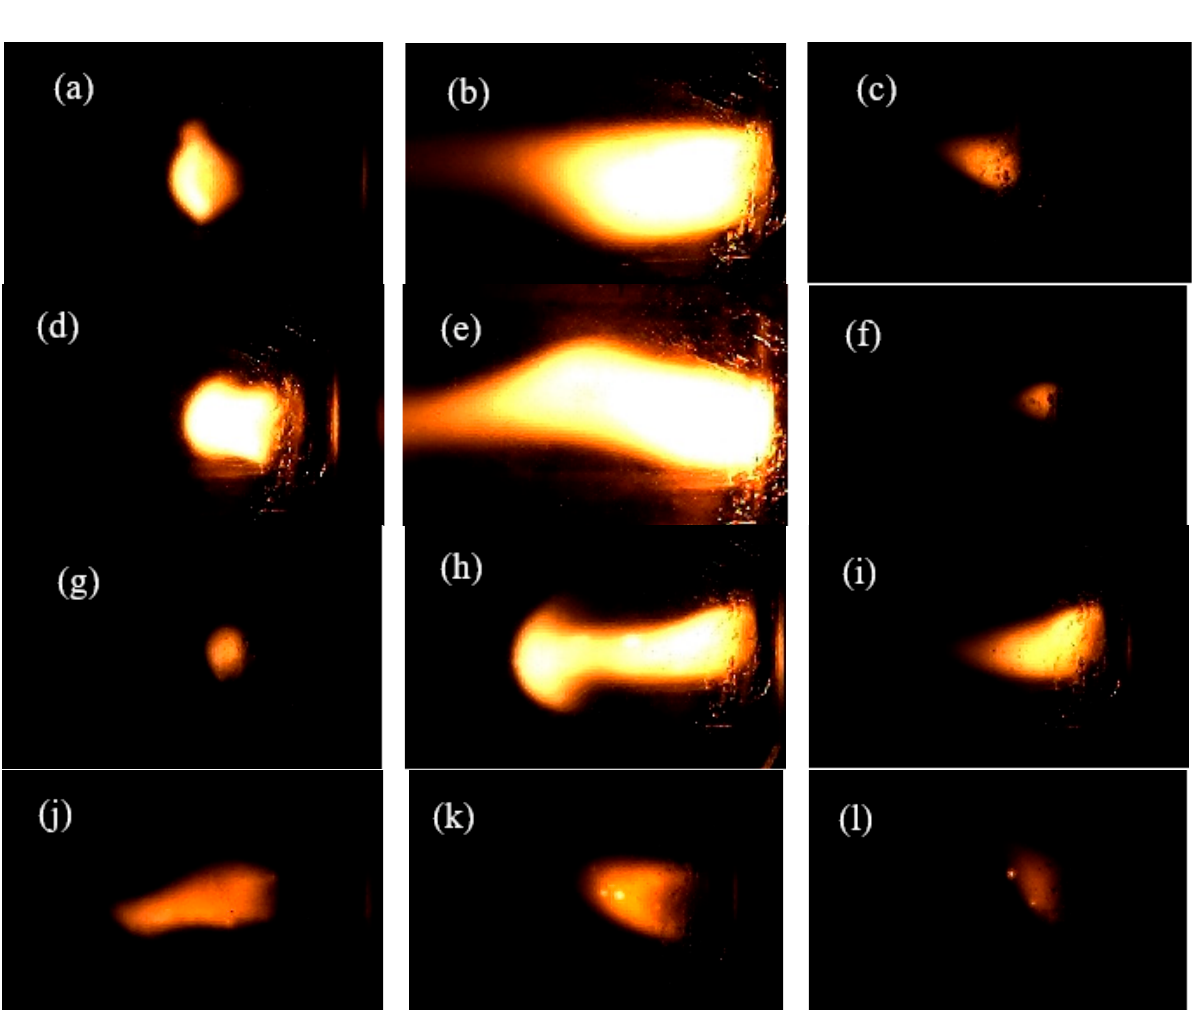
Table 3. The test results of mechanical sensitivity.